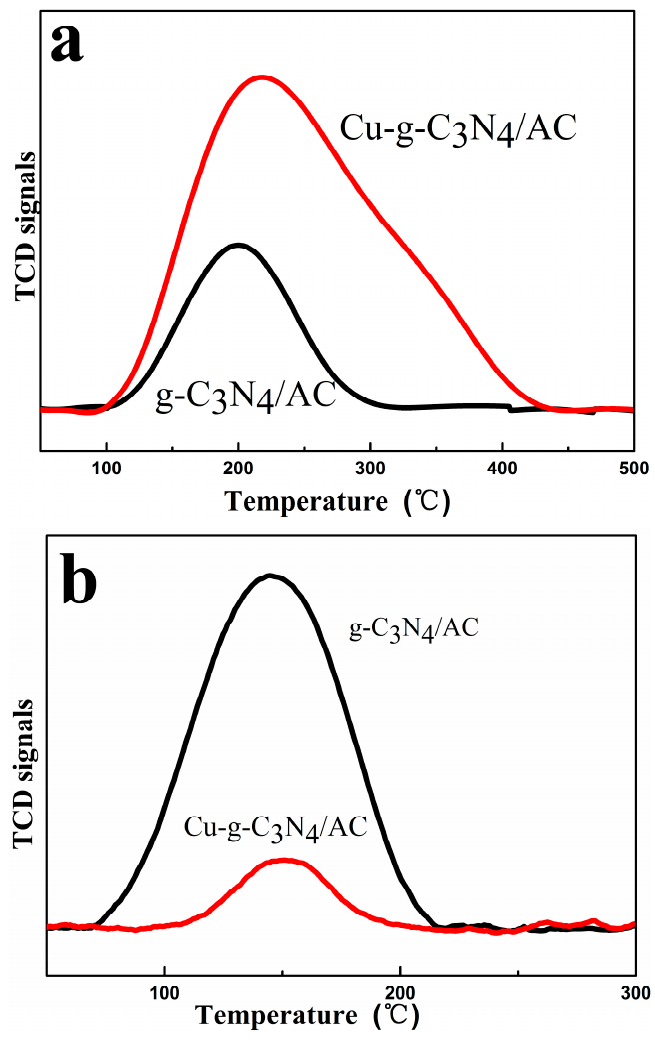
Figure 6. Temperature ‐ programmed desorption (TPD) profiles of Cu ‐ g ‐ C 3 N 4 /AC and g ‐ C 3 N 4 /AC: ( a